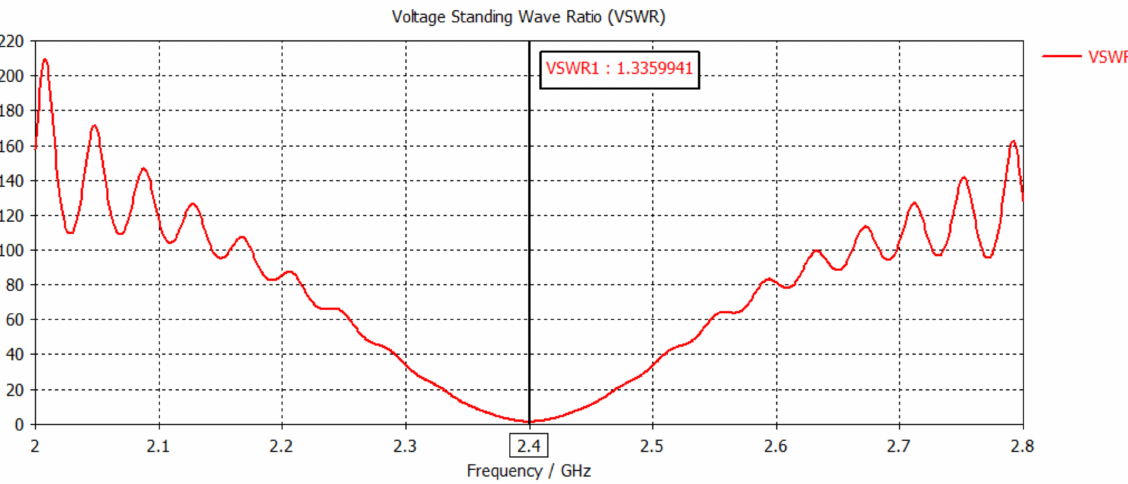
Figure 17. VSWR by frequency in new design of patch antenna of 2.4 GHz with line transmission λ